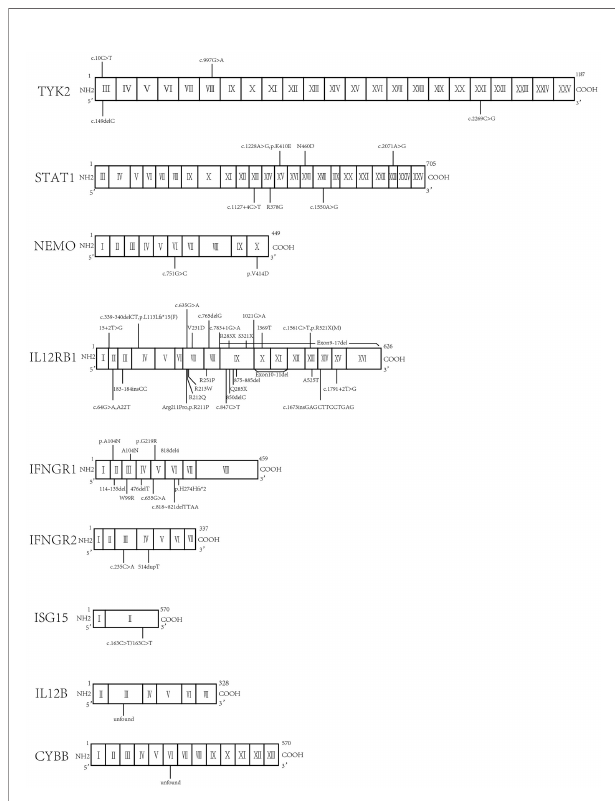
FIGURE 3 | Molecular fi nding of all the mutations in Chinese